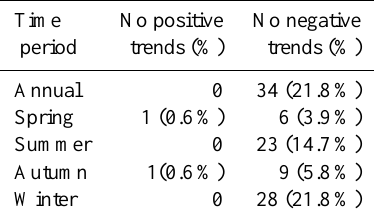
Table 3. Number and proportion of series with trends in the number of events in the fifth quintile (Q5), significance level α = 0 .